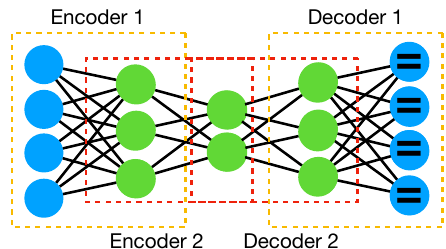
Figure A2. Network architectures. ( a ) Autoencoders; ( b ) Deep belief networks.